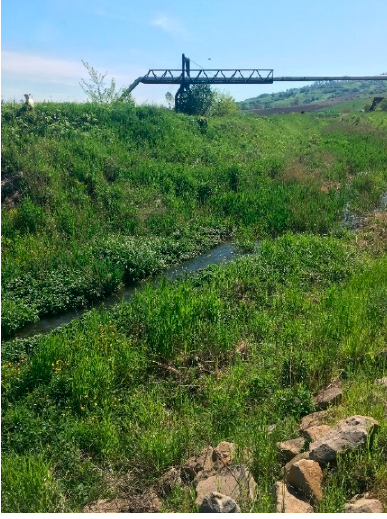
Figure 6. Biertan River non-refuge sector.